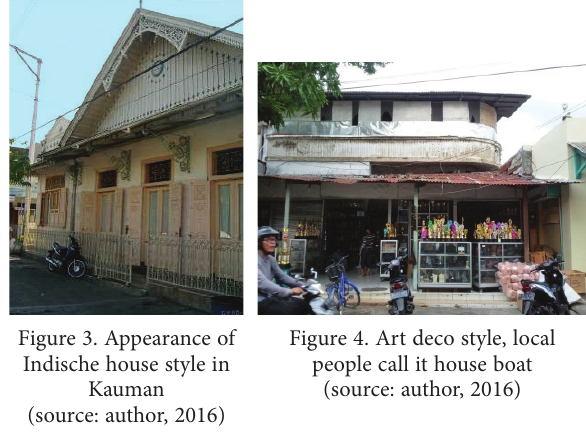
Figure 3. Appearance of Figure 4. Art deco style,